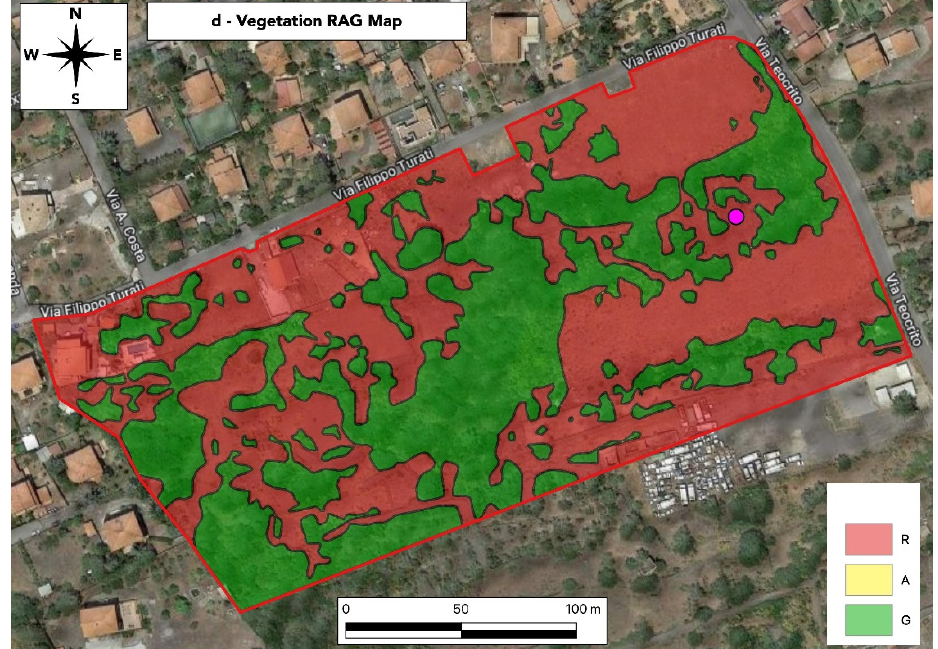
Figure 15. RAG map of the “Vegetation” layer of the GIS platform. The burial site (pink circle) fell on the Red coded area. For the percentages of RAG color-coded areas see Figure 11 (the Amber-coded area is not visible covering the 5% along the Red and Green area boundary).